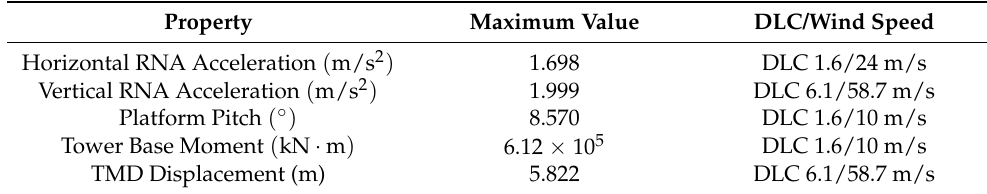
Table 26. Maximum platform motions.